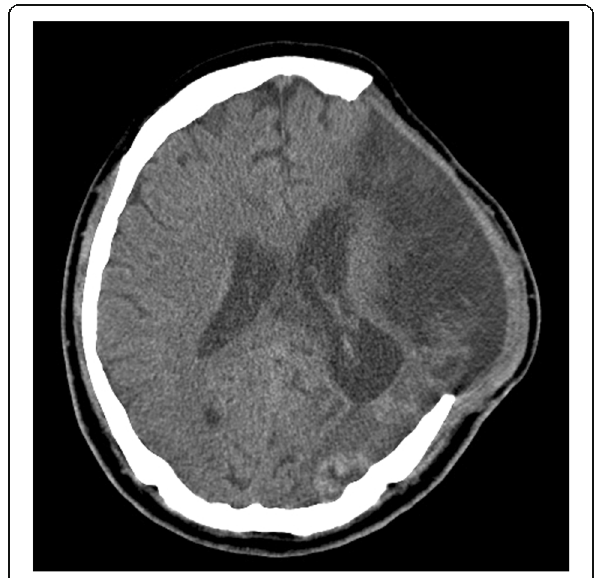
Fig. 2 Axial computed tomography scan after decompressive hemicraniectomy